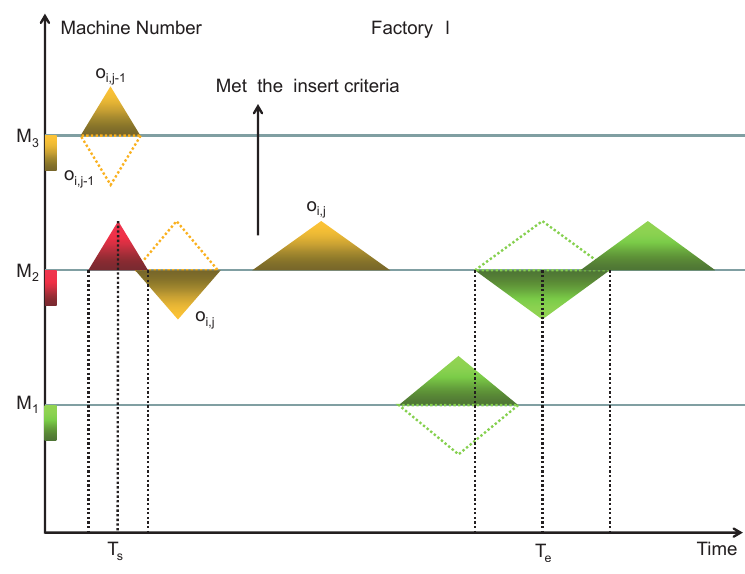
Figure 3. An example of the insert decoding